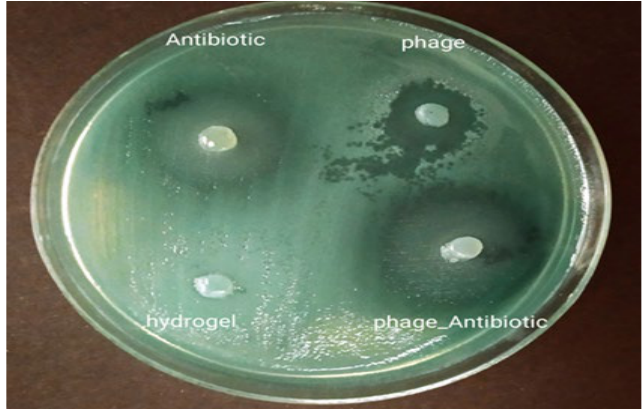
Figure 9. Inhibition zones of the hydrogels against P. aeruginosa .